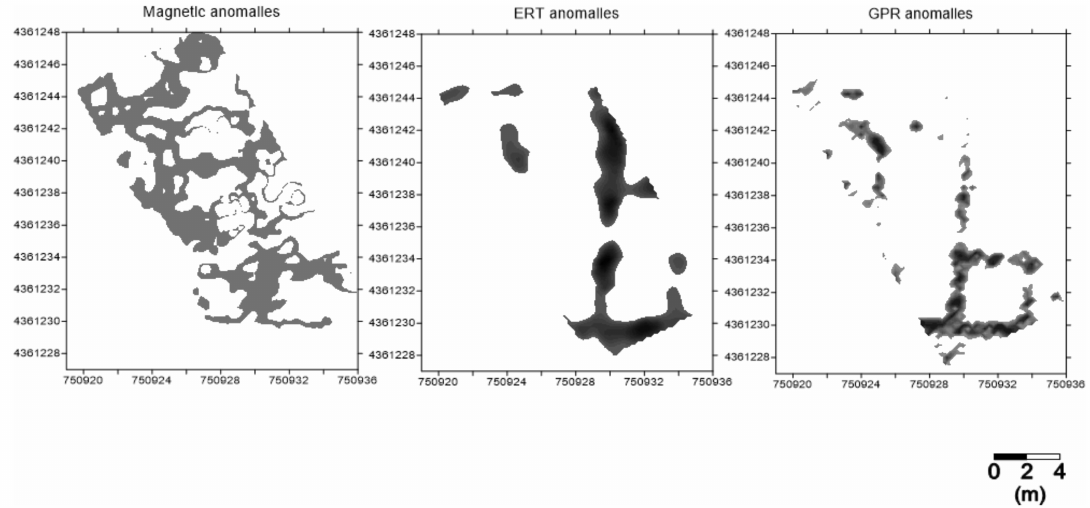
Figure 12. Selection of the anomalies corresponding to walls from the results of the magnetic method, ERT and